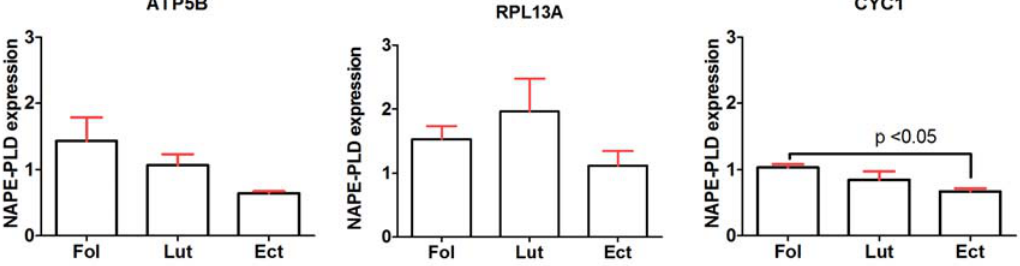
Figure 5. NAPE-PLD expression in human endometrium using each of the 12 candidate reference genes as internal control. Samples were from the follicular (Fol, n = 4), luteal (Lut, n = 4) phase and ectopic pregnancy (Ect, n = 4). Relative NAPE-PLD expression